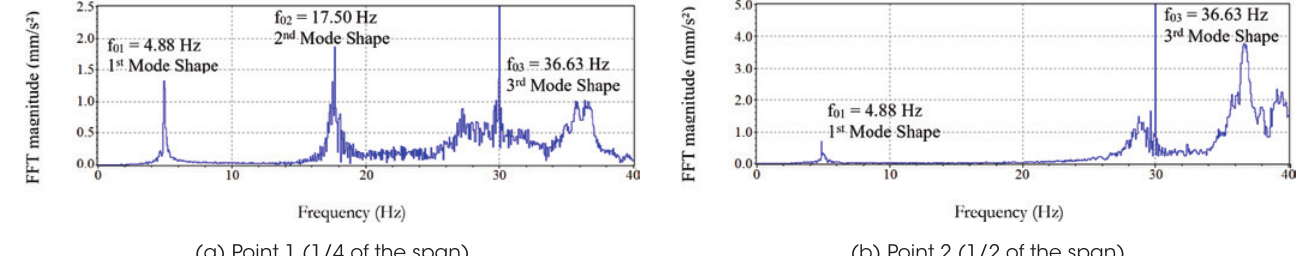
Experimental FFT magnitudes of the footbridge vibration modes (Test 3)